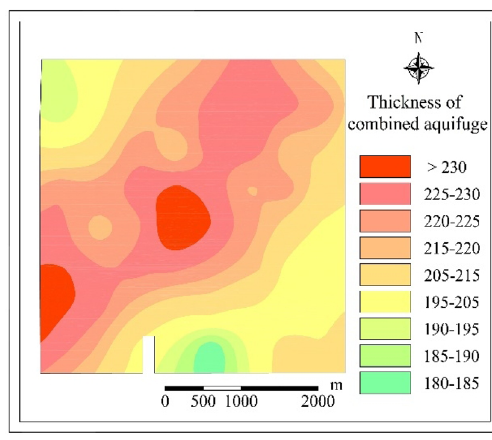
Fig. 7 Thickness of the combined